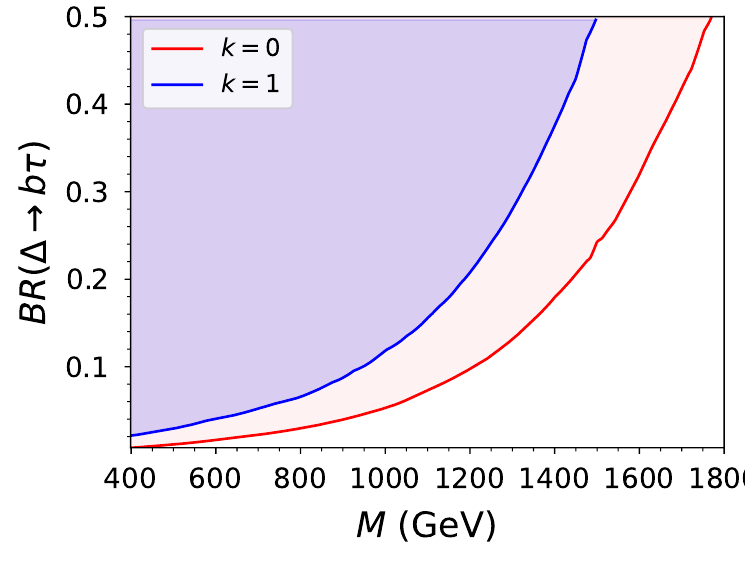
Figure 5 . Reinterpretation from [113]. The main assumptions are BR (∆ → bτ ) = BR (∆ → tν ) and that the opened second generation decay is invisible to the analysis, and hence only affects the fiducial cross-section 2 × σ ( pp → ∆∆ ∗ ) × ( BR 3 rd ) 2 ∆